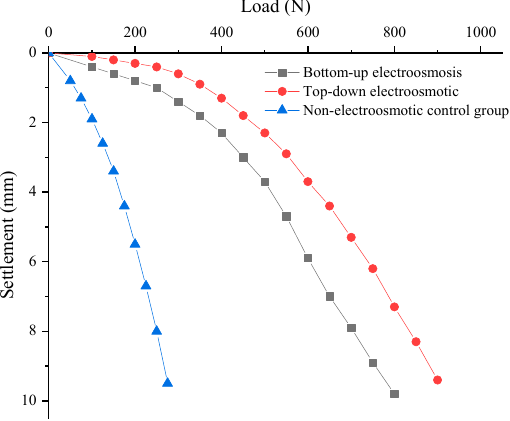
Figure 14. Load settlement curve of different groups.